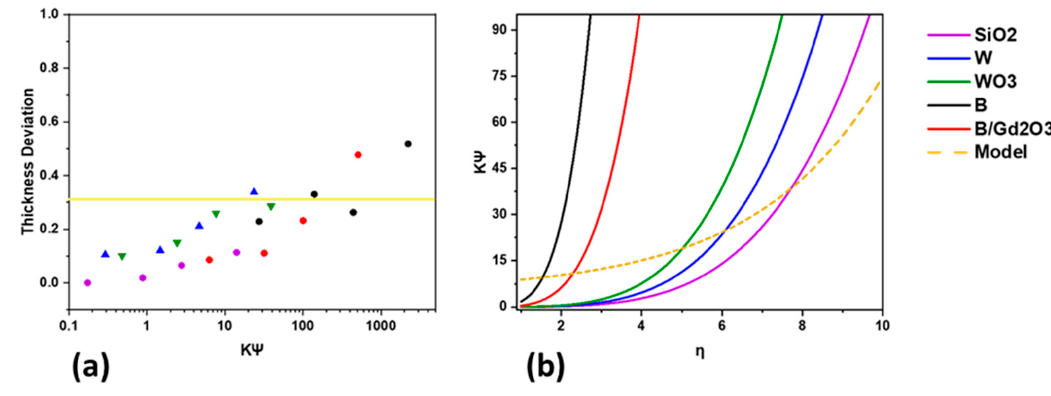
Figure 5. Determining how the structure parameters are related to spacing ratios, where ( a ) the thickness deviation is plotted against K ink Ψ lattice , with a yellow line at the one standard deviation mark denoting whether a print was acceptable, and ( b ) K ink Ψ lattice plotted against the spacing ratio along with the model presenting the upper bound for the structure parameters.